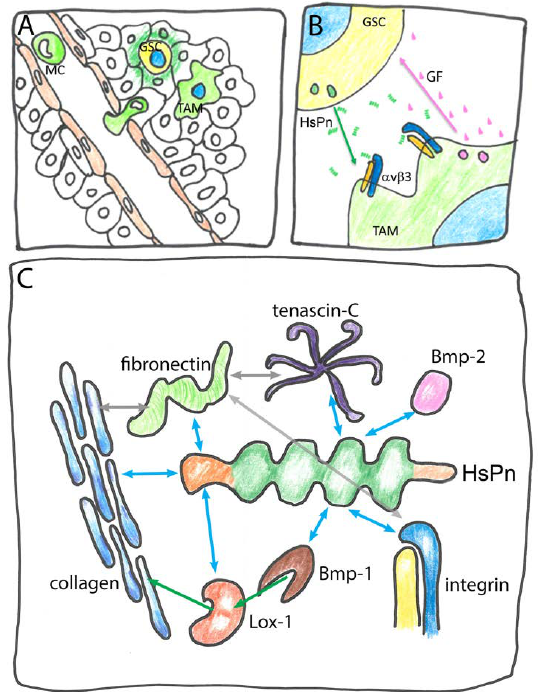
Figure 4. Multiple roles of HsPn: ( A ) Circulatory monocytes (MC) are attracted by glioblastoma stem cells (GSC) that secrete HsPn (dark green) to invade the site of the primary tumor and differentiate into tumor associated macrophages (TAM); ( B ) GSC-secreted Pn via integrin αvβ3 signaling triggers the release of growth factors (GF) that establish a metastatic niche; ( C ) molecular interactions of Pn in the ECM. Blue double arrows indicate binding of HsPn. Grey double arrows indicate binding of other components. Green arrows indicate activating reactions: the metalloprotease Bone morphogenetic protein Bmp-1 proteolytically activates Lysine oxidase 1 (Lox-1) in turn enhancing collagen crosslinking.